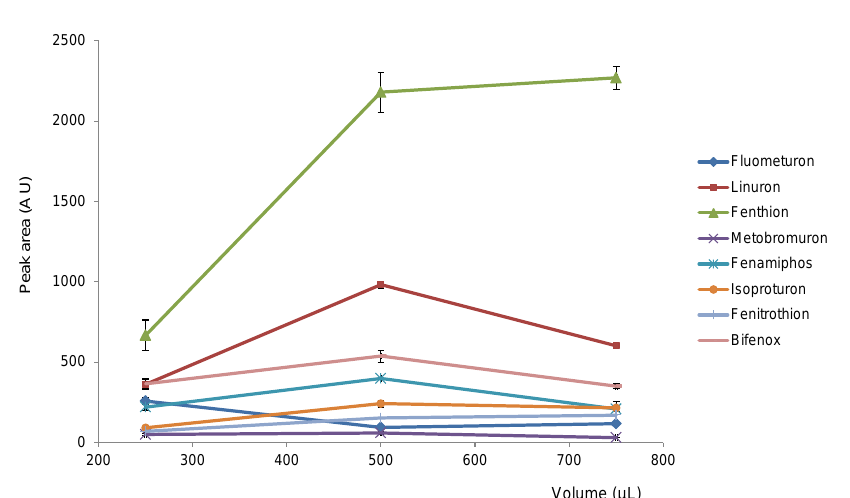
Figure 3. Variation of the peak areas with the sample volume with the TEOS-MTEOS extractive phase reinforced with TiO 2 NPs. Concentration assayed, 25 ng/mL for linuron and 10 ng/mL for the rest of compounds.